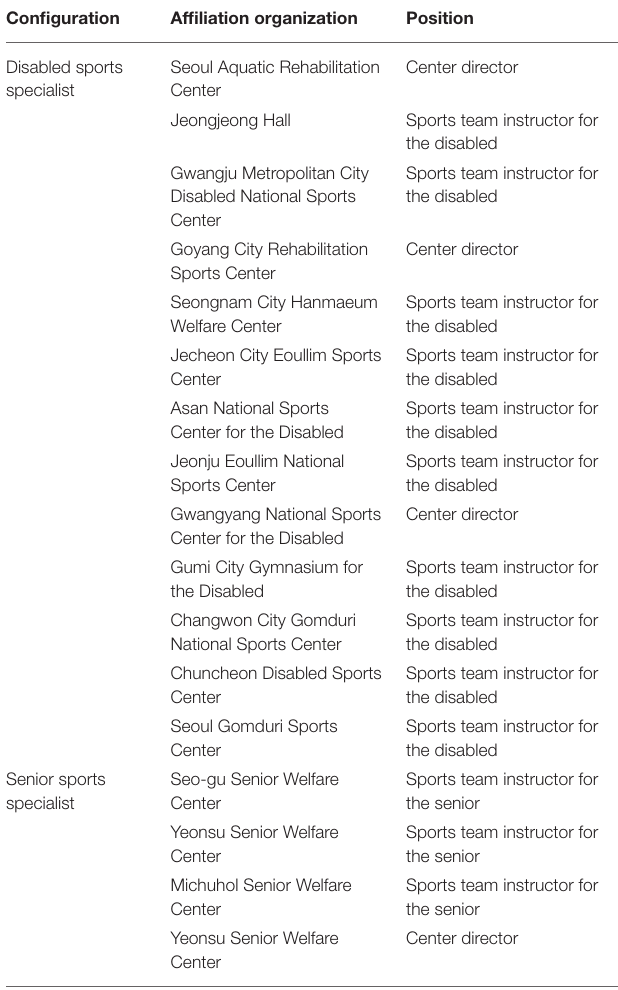
TABLE 1 | Delphi panel configuration.